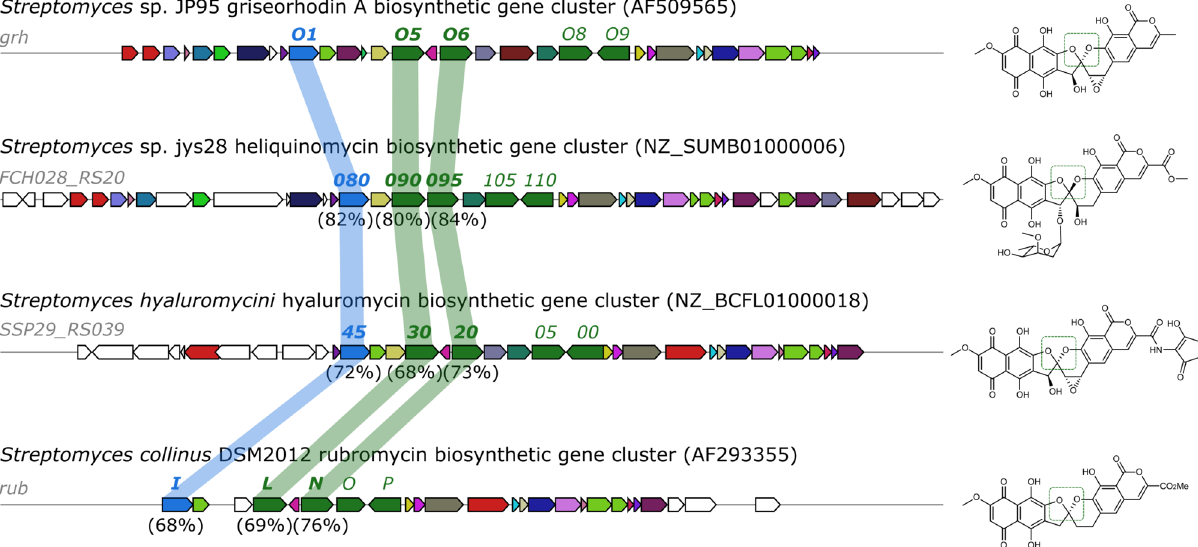
Fig. 5 Gene cluster comparison performed with MultiGeneBlast 29 . Same colors indicate high amino acid sequence similarities and predicted similar functions. The biosynthetic gene clusters for production of the spiroketal-containing compounds griseorhodin A ( 1 , AF509565), heliquinomycin (NZ_SUMB01000006), hyaluromycin (NZ_BCFL01000018), and rubromycin ( 2 , AF293355) are shown. These clusters harbor grhO5 (green), grhO1 (blue), and grhO6 (green) homologs. Corresponding homologs are connected with a shadow and the percentages of the amino acid sequence identities of the encoded proteins are shown. The grhO8 and grhO9 genes also show homology to grhO5 and grhO6 and encode FAD-dependent monooxygenases involved in early redox tailoring steps. The biosynthetic gene clusters of the non-spiroketal pentangular polyketides lack grhO1 , grhO5 , and grhO6 gene candidates necessary for spiroketal formation (see Supplementary Fig. 51 for full